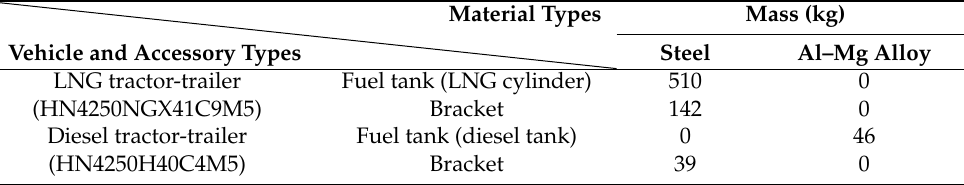
Table 2. The differences in accessory materials between the two alternative